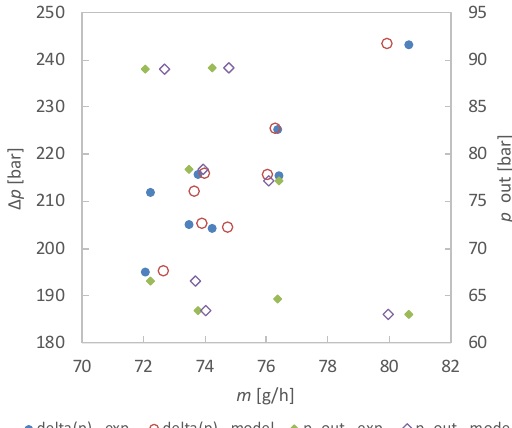
Fig. 7. CO 2 mass flow rate through isothermal capillary tube CAP 3 ( d = 0.095 mm, L = 7.8 m) versus pressure drop over the capillary tube and outlet pressure after the capillary tube. Experimental data versus model.